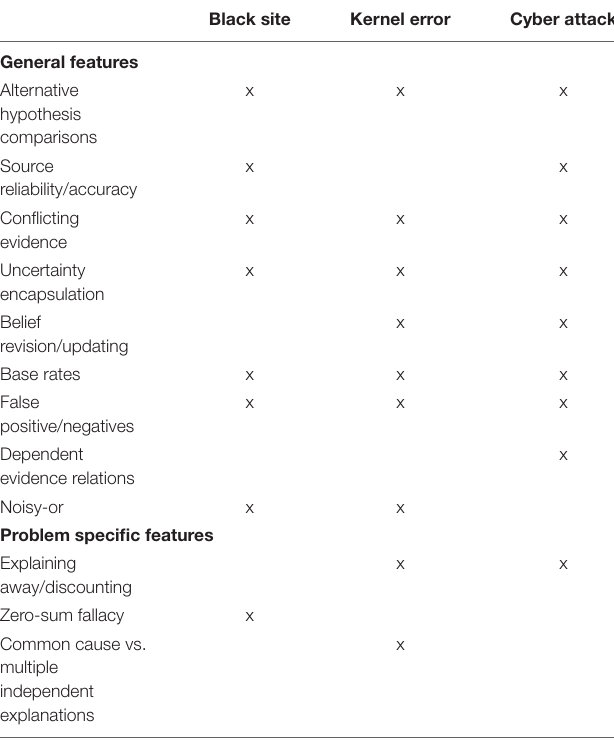
TABLE 1 | Features measured by the three problems in the